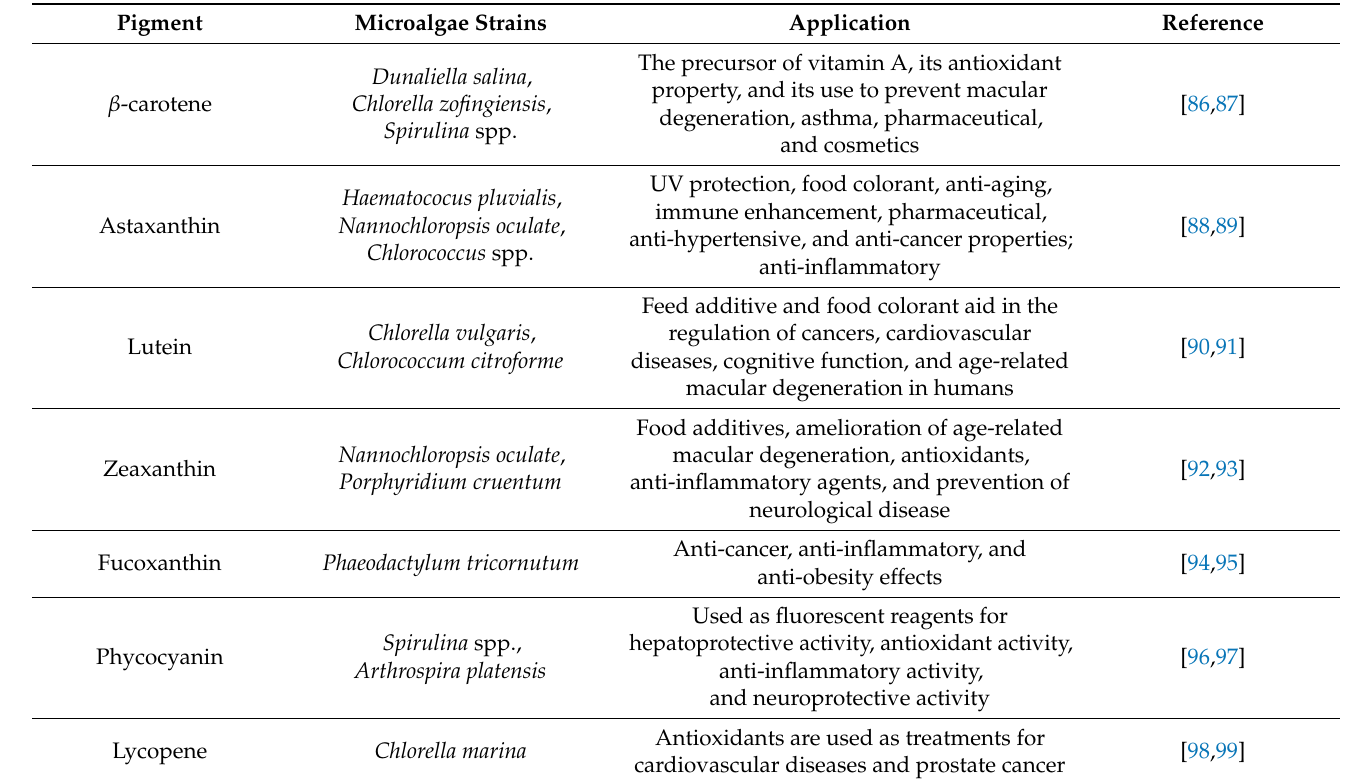
Table 2. Potential role of bio pigments from